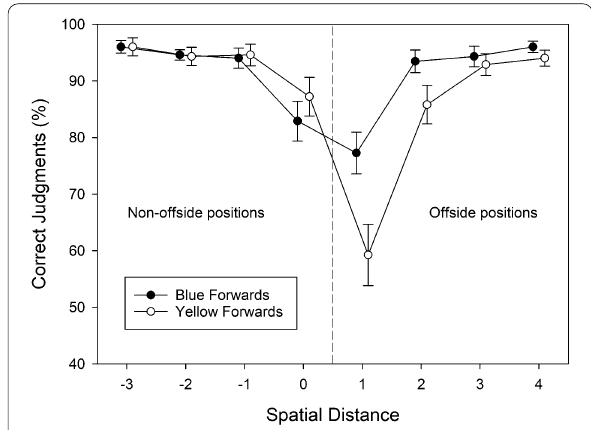
Fig. 8 The percentage of correct offside judgments observed in Experiment 3, plotted as a function of spatial distance (between forward and defender) and shirt color of the attacking team (blue vs. yellow). Error bars represent standard errors between participants. For each level of spatial distance, data points are jittered to increase